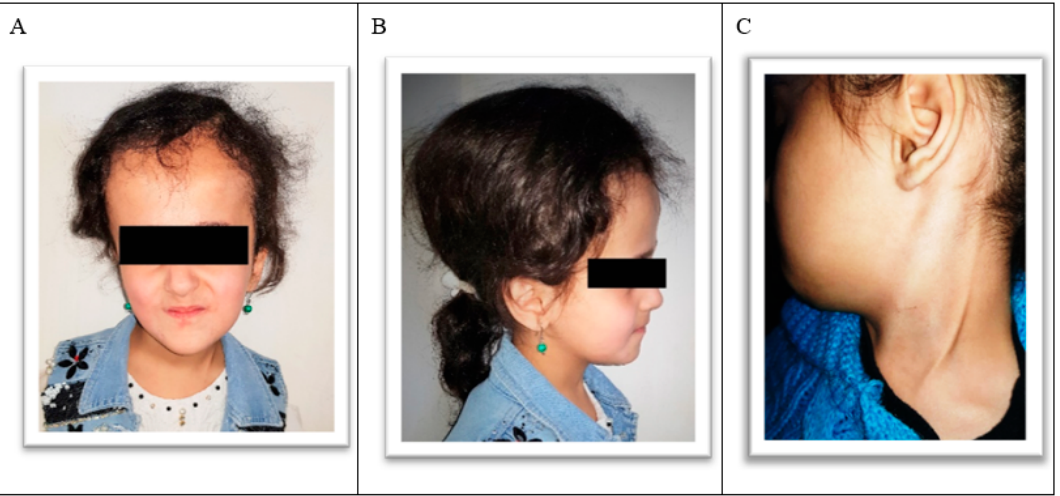
Figure 1. ( A ) Frontal view of the child. ( B ) Lateral view of the child. Note the enlargement in the head’s posterior region due to hydrocephalus. ( C ) The ventriculoperitoneal (VP) shunt in the neck’s left side.